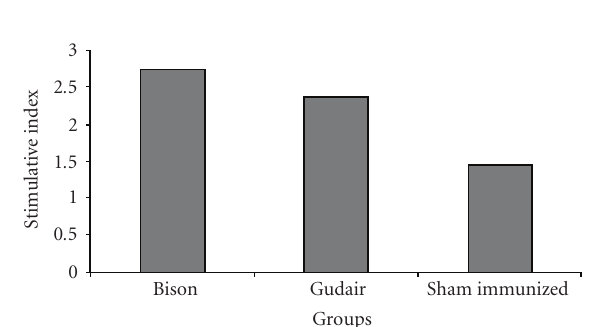
Figure 2: Comparison of Cellular Immune response (Stimulation Index) in two vaccine groups and a sham-immunized group at 60 days post vaccination.